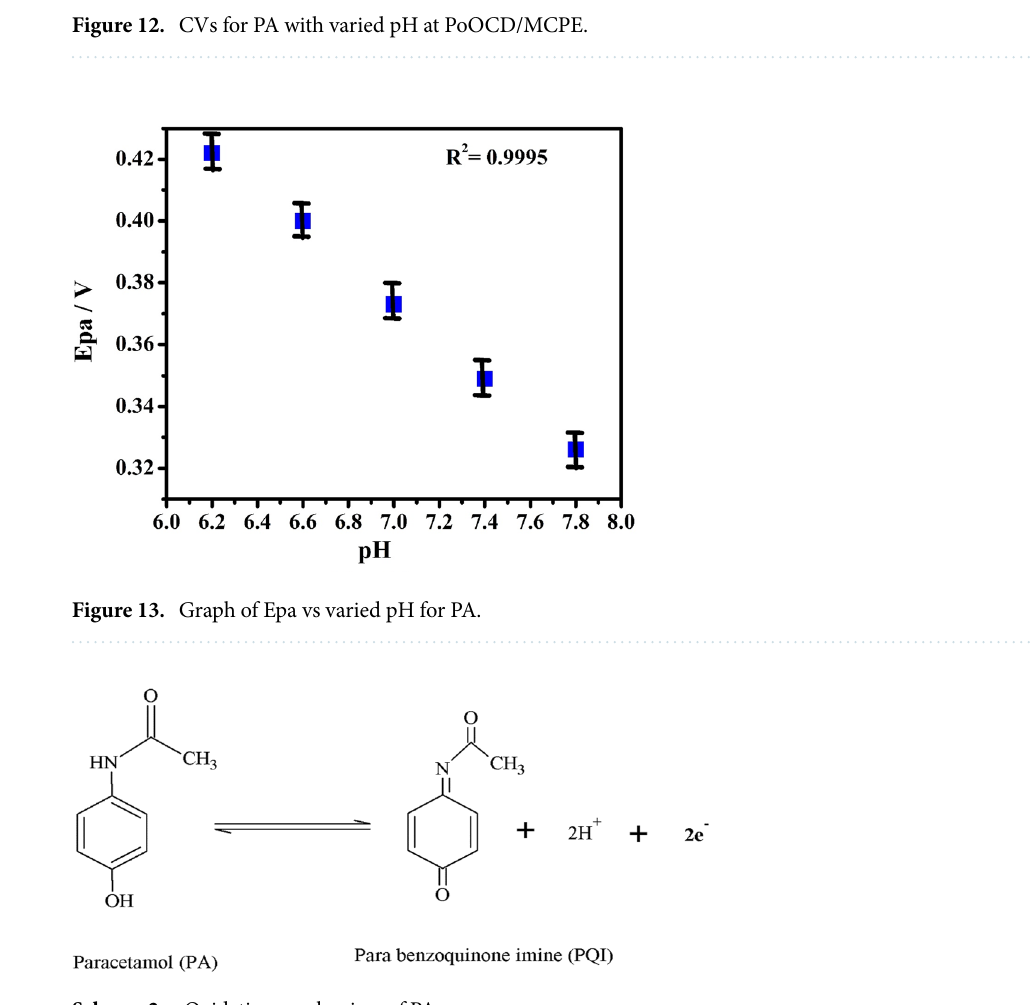
Scheme 2.. Oxidation mechanism of